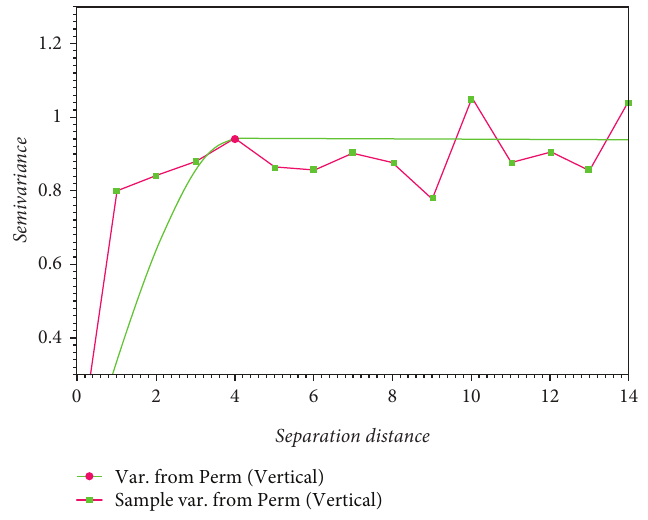
Var. from Perm (Vertical) Sample var. from Perm (Vertical) Figure 9: Variogram of vertical direction.